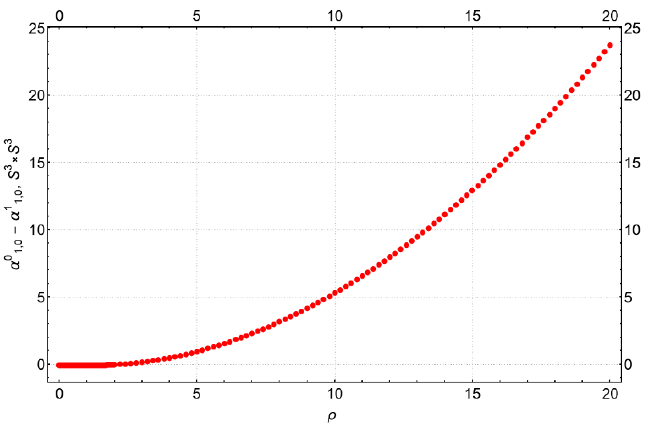
Figure 4 . The di(cid:11)erence (cid:11) 0